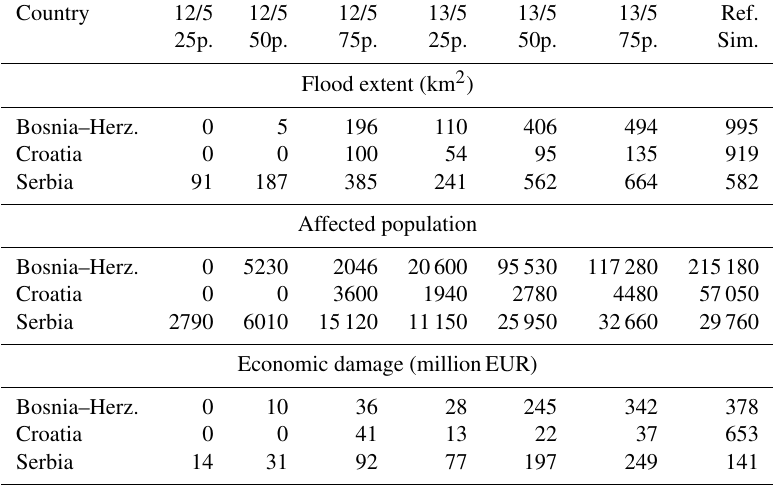
Table 7. Comparison of forecast flood impacts with the reference simulation.